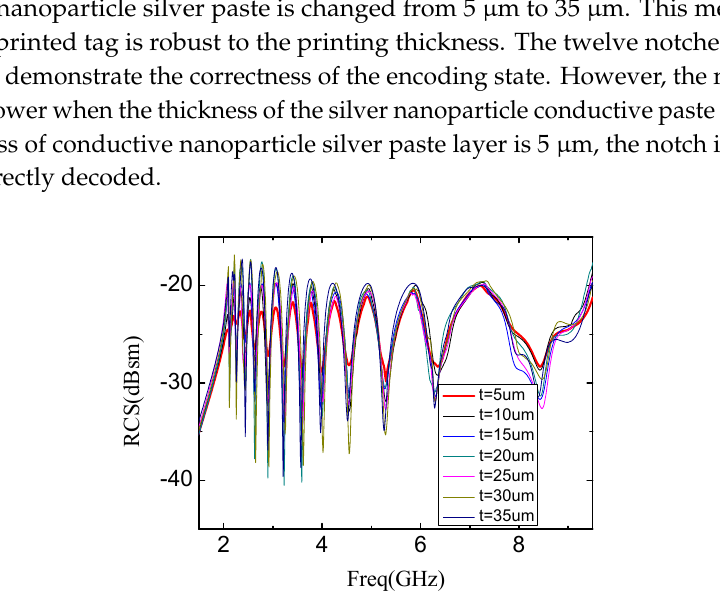
Figure 6. Frequency spectra of the 12 ‐ bit ‐ tag on F4BM substrate. The thickness of substrate is 1 mm.